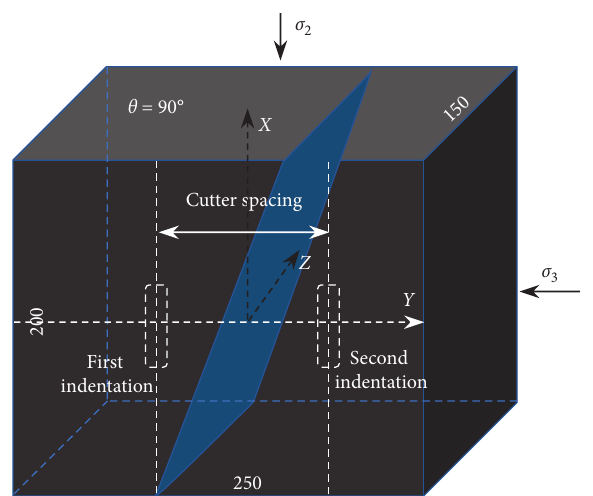
Figure 2: Two indentations of layered specimen used by TBM disc